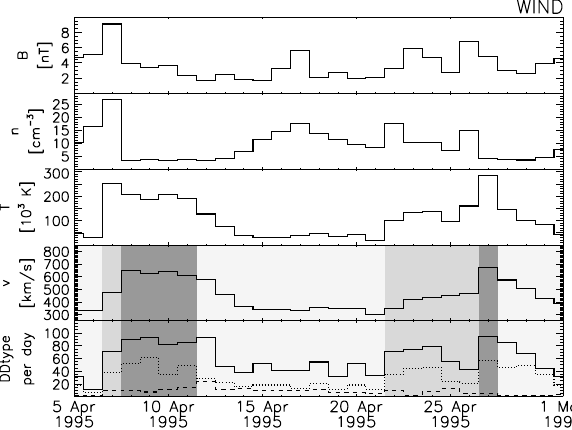
Fig. 10. Daily averages of B , n , T , v and the rates DD per day for overall DD (solid), RDs (dotted) and TDs (dashed), for example, for Wind for the TS and B criteria, respectively; shaded regions repre- sent different solar wind states: peak region of v (dark), trailing edge (light), leading edge